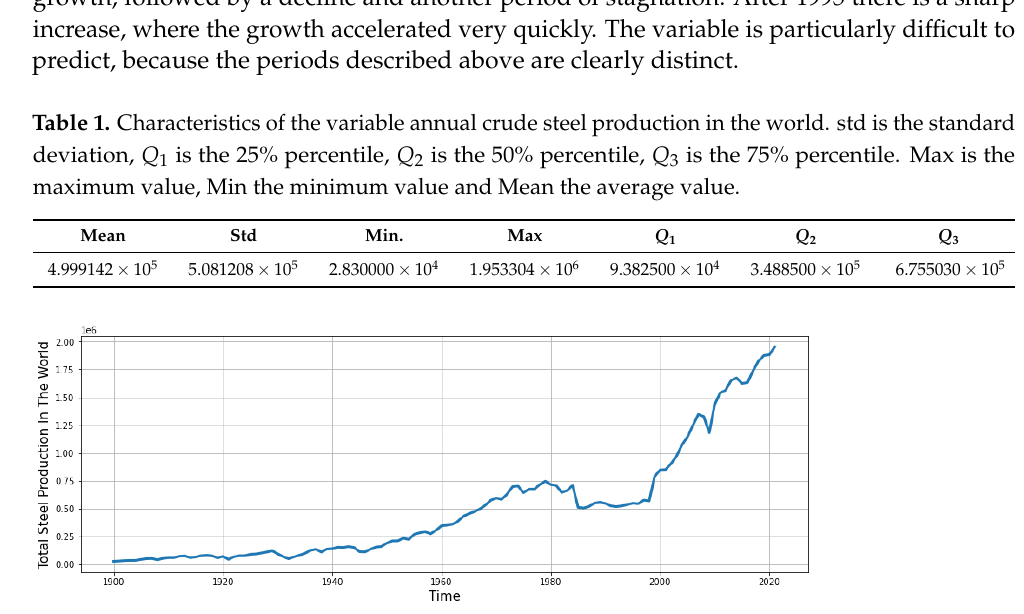
Figure 7. Annual crude steel production in the world, in millions of metric